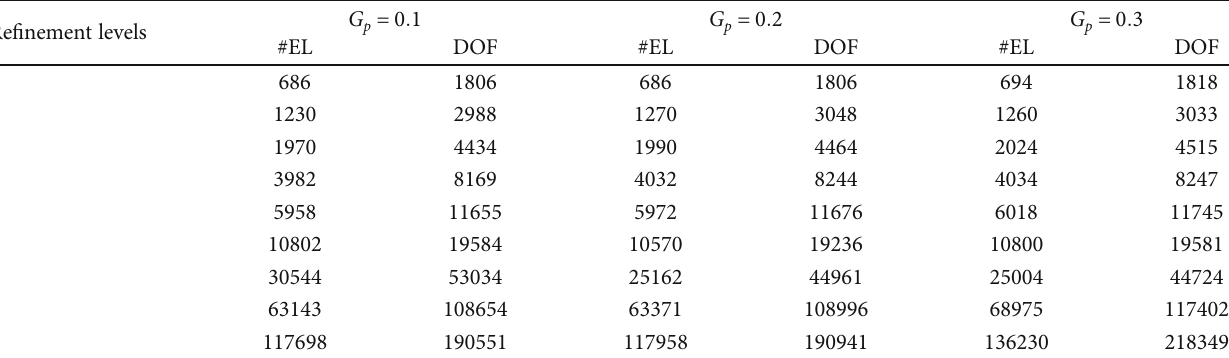
Table 2: In fl uence of Bn and separation distance on drag coe ffi cient C